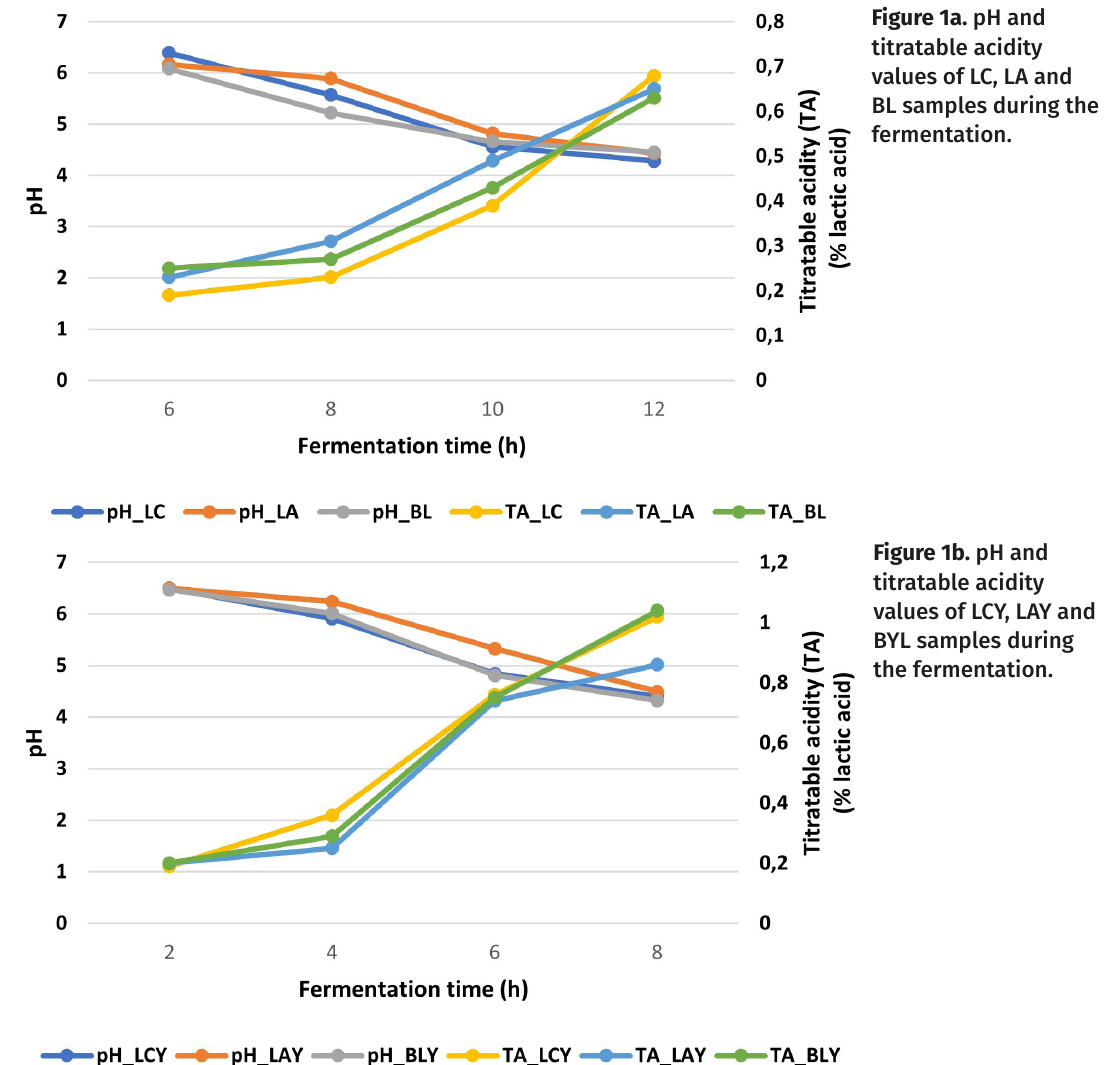
Figure 1a. pH and titratable acidity values of LC, LA and BL samples during the